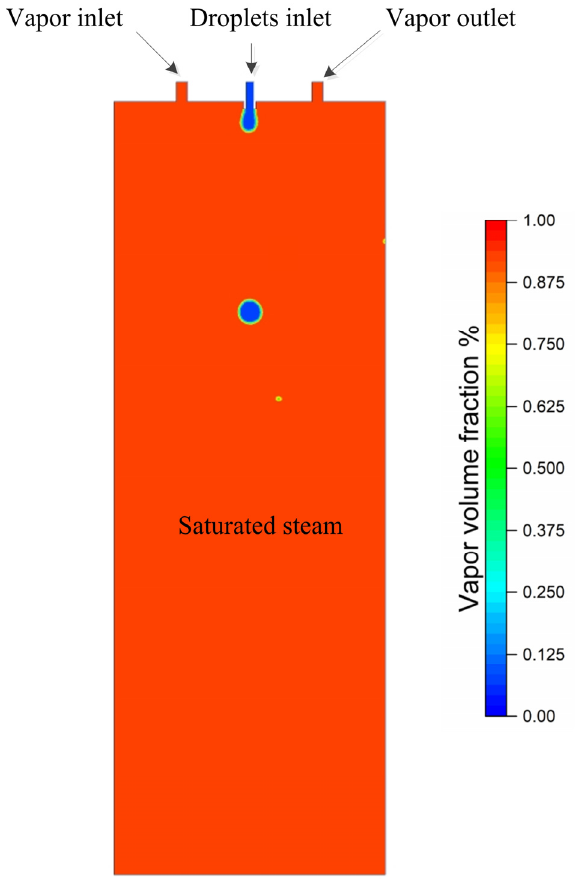
Figure 2. Volume fraction of vapor.